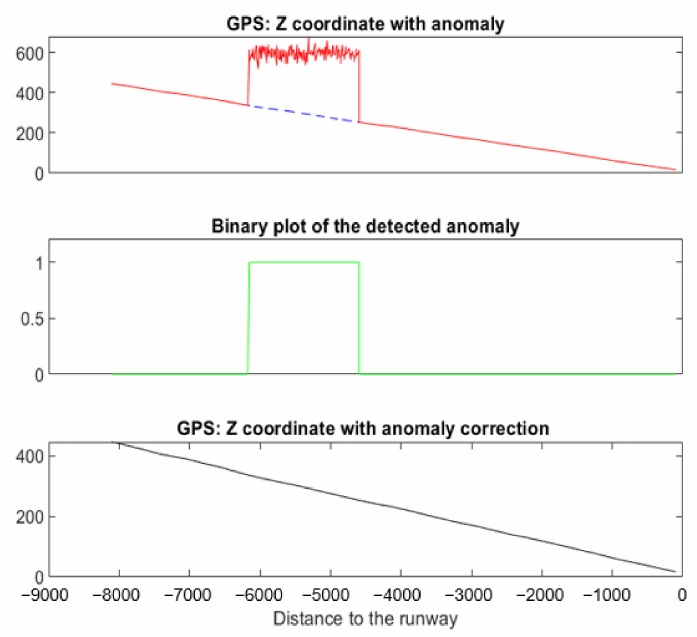
Figure 27. Noisy bias anomaly detected and corrected on a specific landing using NADCA.